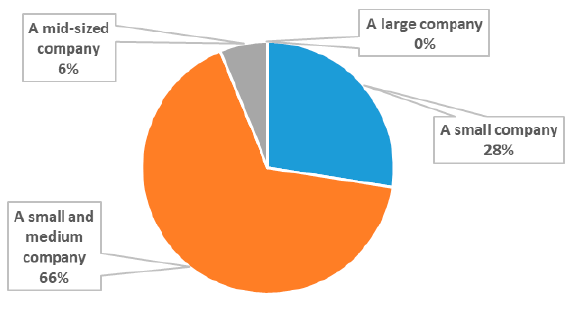
Figure 3. Company type.